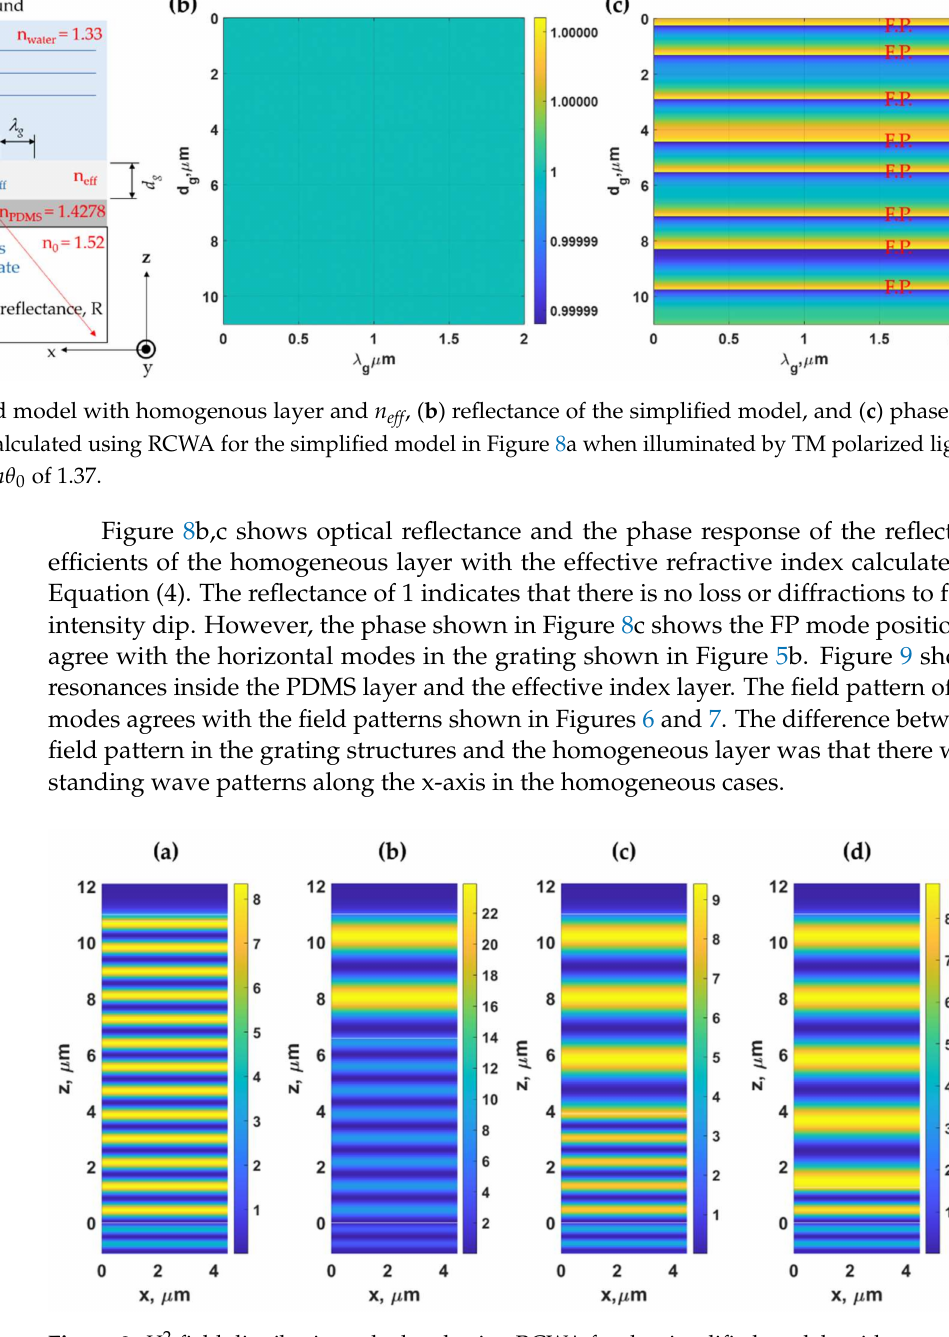
Figure 9. H 2 y field distribution calculated using RCWA for the simplified models with n eff calculated with F.F. of 0.5, d of 11 µ m, and ( a ) d g of 0.24 µ m, ( b ) d g of 4.42 µ m, ( c ) d g of 7.11 µ m, and ( d ) d g